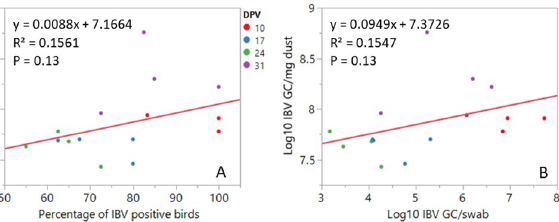
Fig 2. Linear association of log 10 IBV GC in dust with the percentage of IBV positive birds in swabs (A) and log 10 IBV GC in swabs (B). Each data point represents the mean value for each one of the four poulty houses on a given